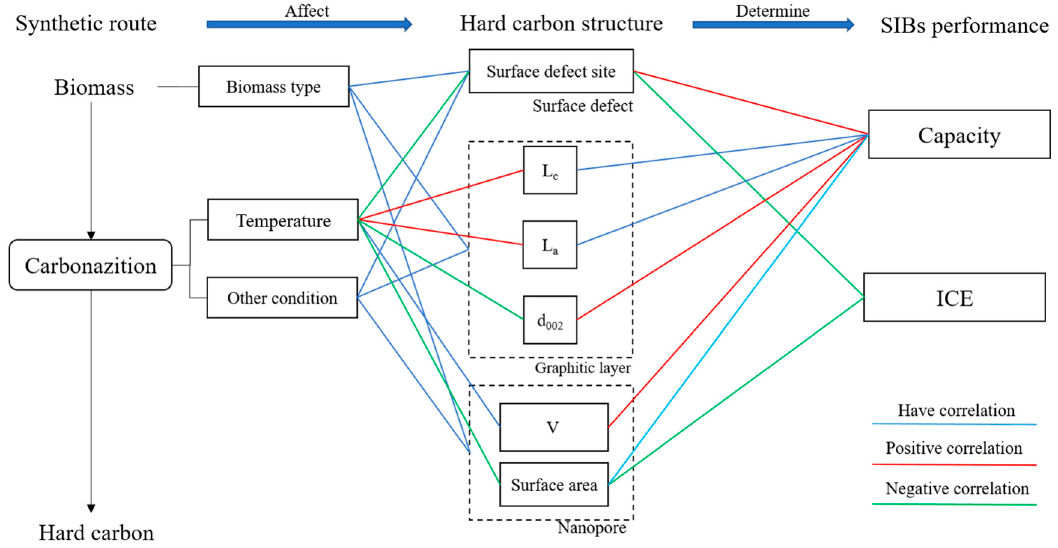
Figure 8. Relationship between the synthetic route, HC structure, and anode performance.